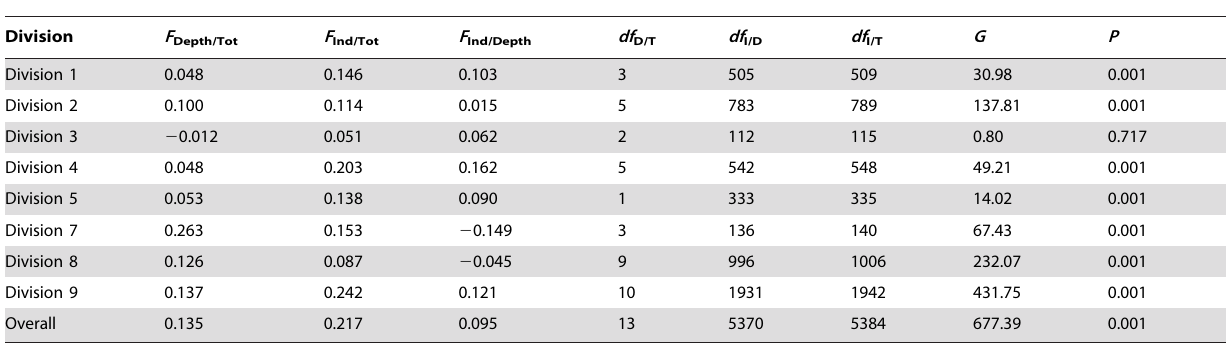
Table 3. F statistics among depth classes within divisions.